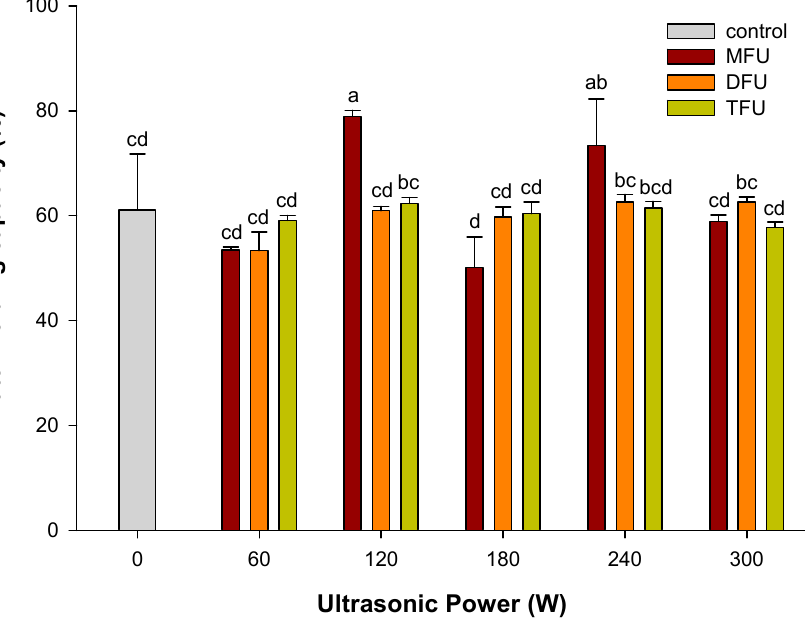
Figure 3. WHC of WPEG with whey protein pretreated by ultrasound at different ultrasonic frequency mode and ultrasonic power. Means with different letters (a–d) differ significantly ( p < 0.05).